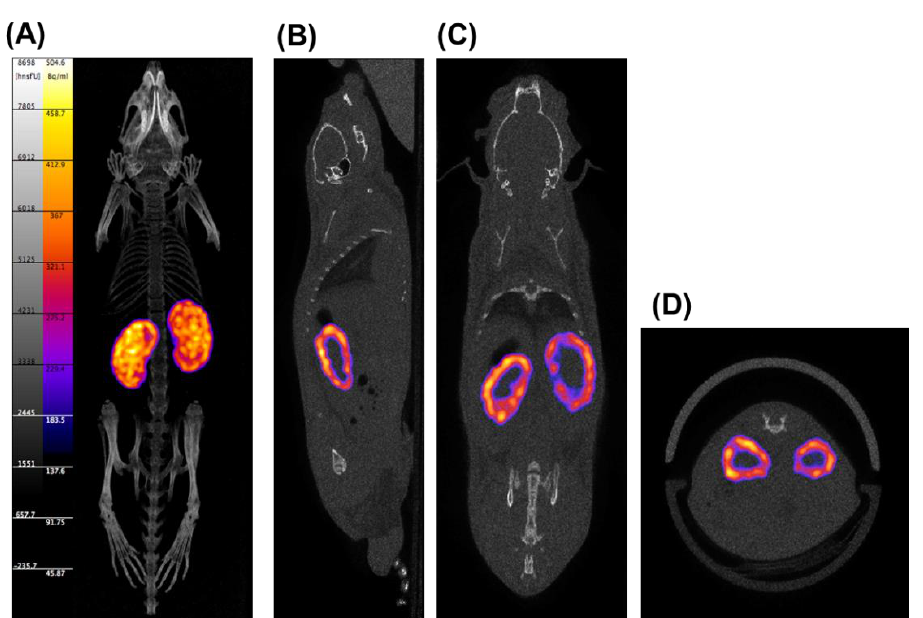
Figure 2. SPECT/CT imaging 180 min after intravenous injection of 111 In-labeled Ser-poly-L-lysine (Ser-PLL) in mice. ( A ) 3D imaging; ( B ) sagittal plane; ( C ) coronal plane; ( D ) transverse plane.